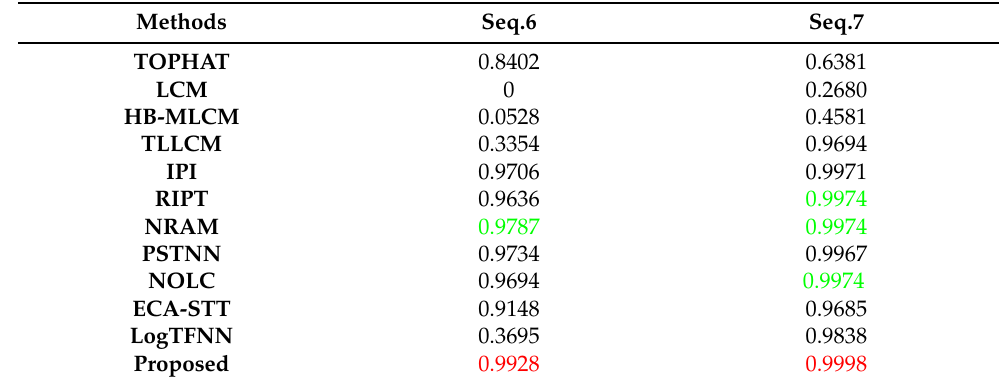
Figure 28. ROC curves of detection results in validation data. Table 8. AUC of different